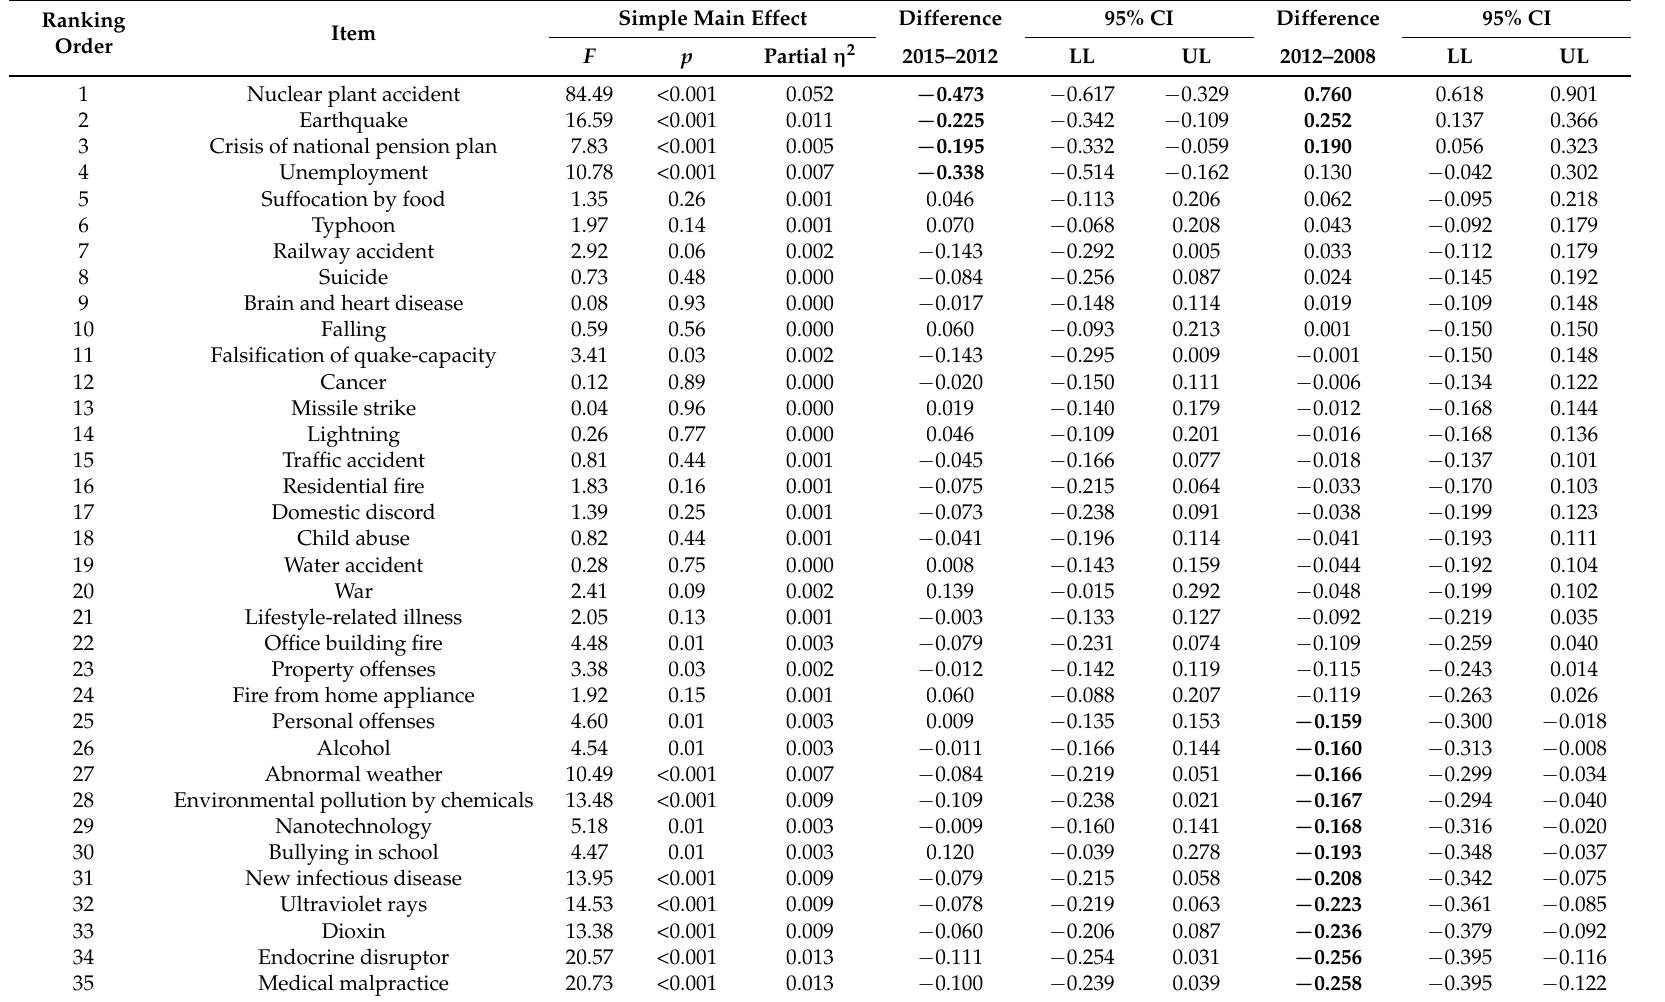
Table 2. The results of the tests of simple main effect and mean differences in anxiety score between the two